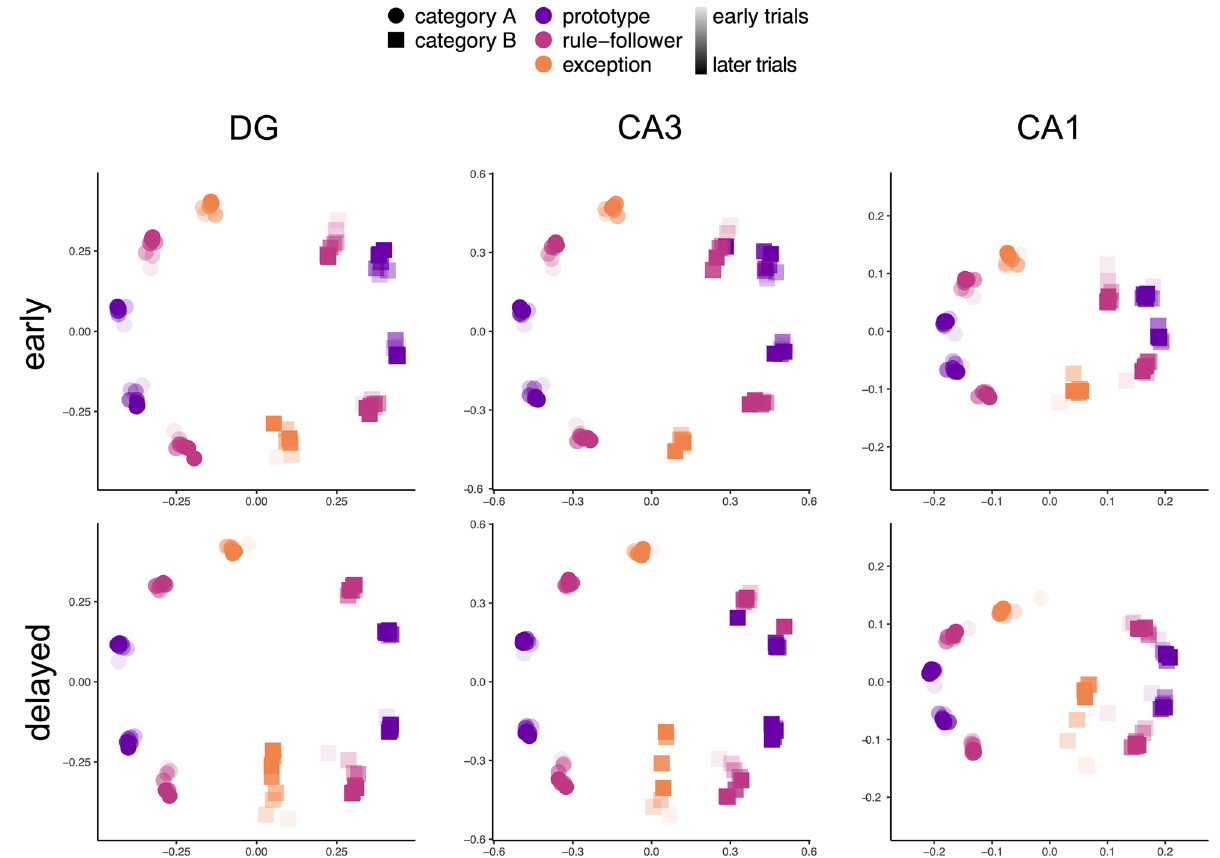
Figure 6. Sammon mapping projections of HC model subfield representations. Two-dimensional projections for stimulus representations within each subfield (columns) in the early (top) and delayed (bottom) sequences. Representations from tests at various time points throughout learning (early: trial 12, 36, 48, 72, 96, 120, 144; delayed: trial 24, 48, 60, 72, 84, 96, 120, 144) are depicted within the same plot with increasing opacity for later time points. The model clearly represents the space well after a limited number of trials. Category coding was apparent across subfields and sequences with category A stimuli (circles) on the left of the primary dimension and B stimuli (squares) on the right. Although stimulus locations were fairly consistent across subfields, a large shift was observed for exception B (orange square) across learning trials in the delayed condition. This shift was not observed for exception